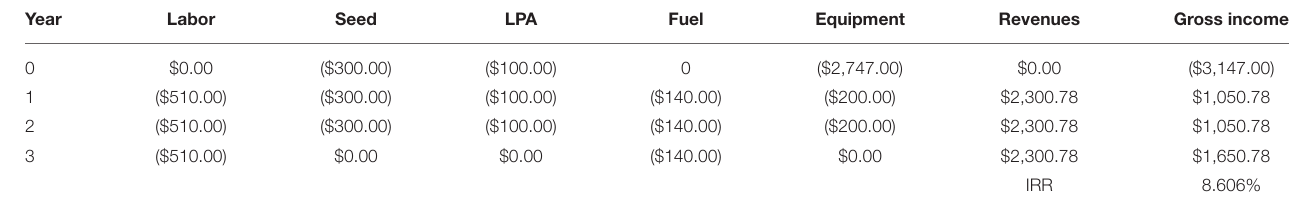
TABLE 4 | Three-year analysis of expenses, revenues, and initial rate of return